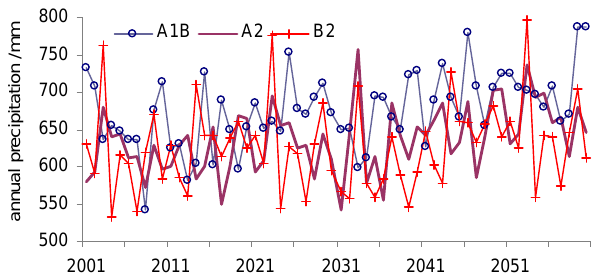
Fig. 7. Projected annual precipitation over China under emission Fig.7. Projected annual precipitation over China under emission scenarios A1B, A2 and scenarios A1B, A2 and B2